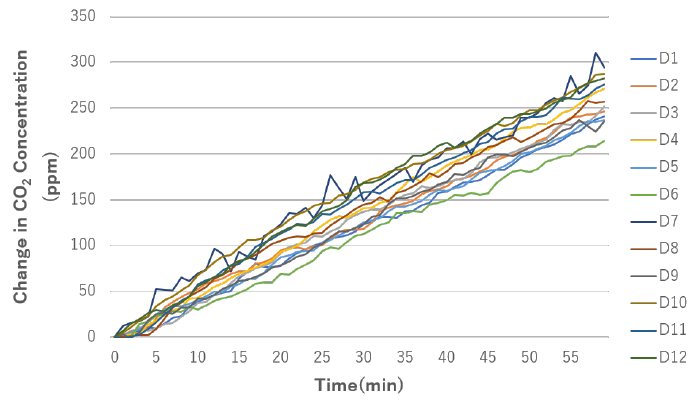
Figure 9. Change in CO 2 concentration in Case3a. DX means Device ID.